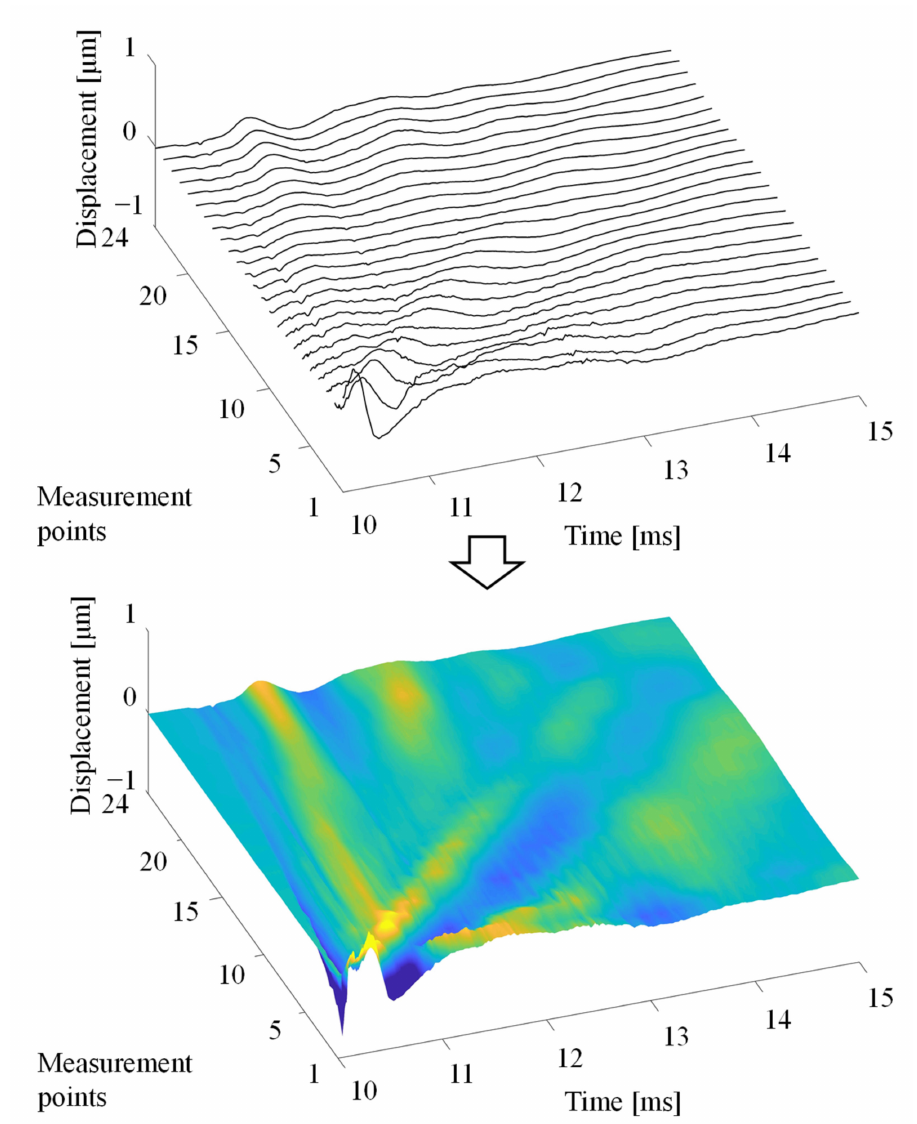
Figure 4. Visualization of Rayleigh wave propagation by arranging the time history responses of the measured